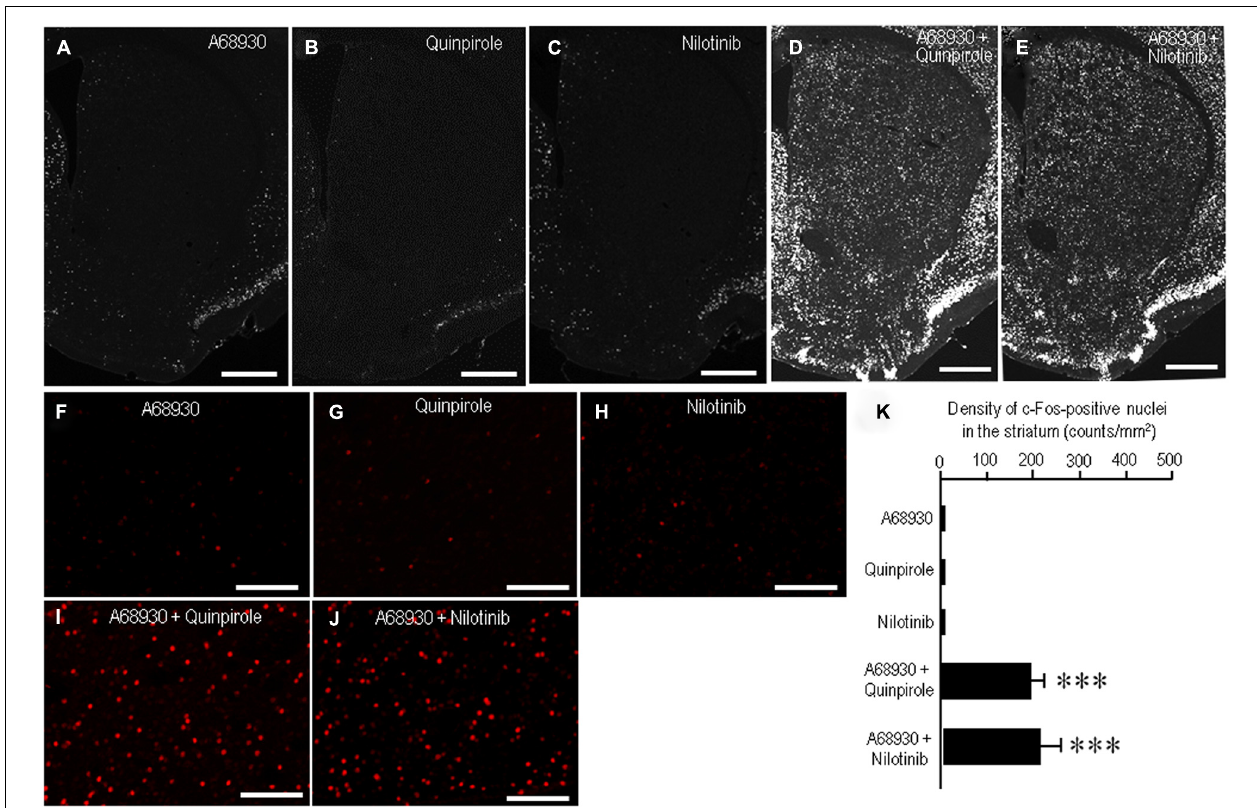
stained for c-Fos from mice treated with A-68930 (A,F) , quinpirole (B,G) , nilotinib (C,H) , A-68930 + quinpirole (D,I) , and A-68930 + nilotinib (E,J) . Scale bar: 1 mm (A–E) , 100 mm (F–J) . (K) Density measurements of c-Fos-labeled nuclei in the dorsal striatum.Values are means ± SEM ( n = 25). *** P < 0.001 versus mice treated with A-68930 alone, those with quinpirole alone, or those with nilotinib alone; unpaired two-tailed t